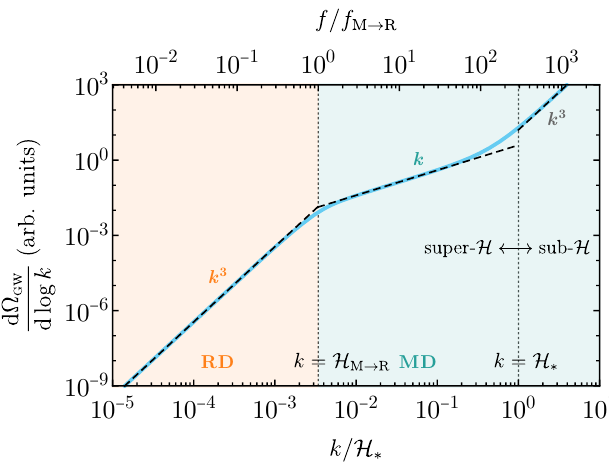
Figure 5 . The spectrum of a GW produced during matter domination. Sub-Hubble causality enforces a k 3 scaling, while super-Hubble scaling gives k during matter domination and k 3 during radiation